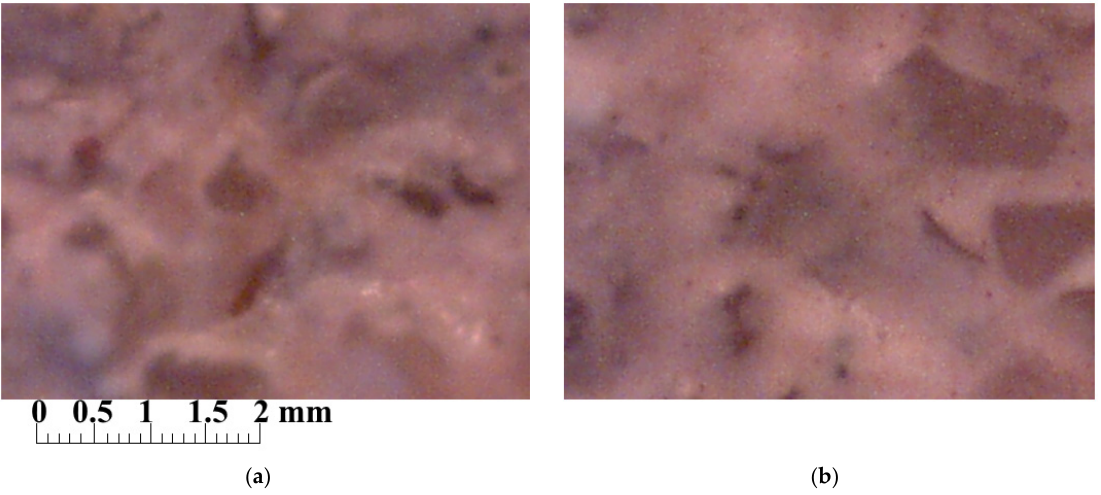
Figure 5. Photographs of the surface of coatings based on the control composition ( a ) and the composition with the addition of silicic acid sol ( b ), ×200.